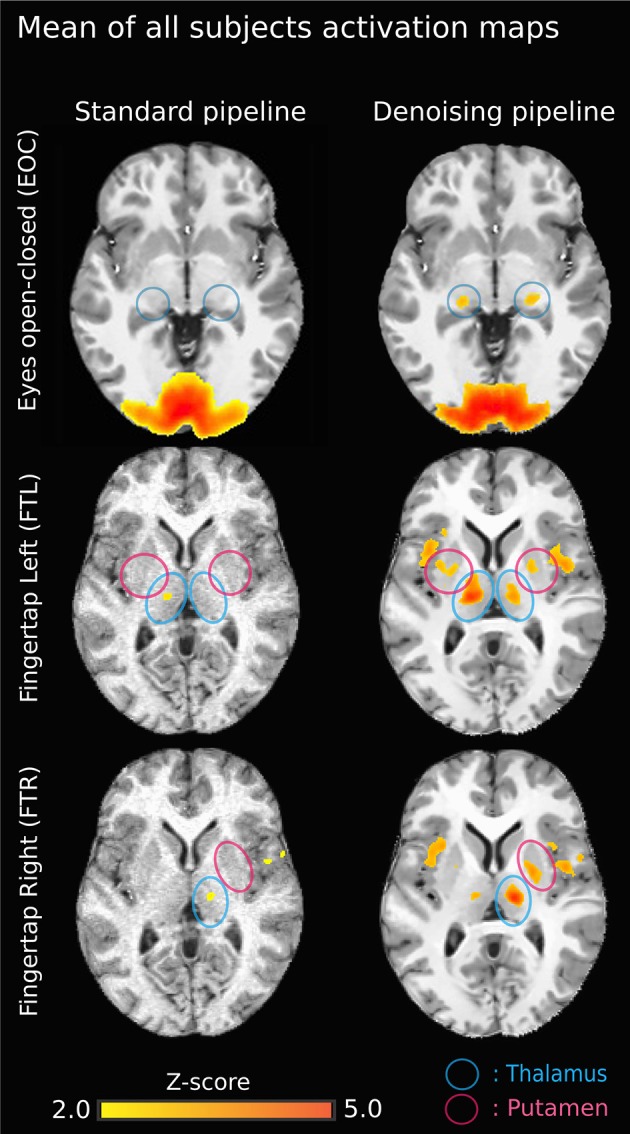
Group-average activation maps (z-score normalized Pearson correlation) using the original pipeline (left) vs. NLM denoising pipeline (right) for each task. Task-activation in sub-cortical areas is more robust using NLM. On the top left image (EOC - standard), the brain activation outside the cortex is mainly due to the gaussian smooth effect. Also, on the standard pipeline “EOC - NLM” image, there is a “spilled” effect caused by the Gaussian smooth, causing some activation to be outside of the cortex. Moreover, the thalamic activation (lateral geniculate nucleus, LGN) is increased (blue circles). Similar results are seen for both finger tapping tasks. The difference between FTl and FTR may be explained by the ratio between left and right-handed subjects. The now present activation in the external capsule may be the result of a veinous effect induced by denoising: NLM denoised the signal in veinous areas, therefore making it possible to isolate activations (with a strong percent change) in these structures.